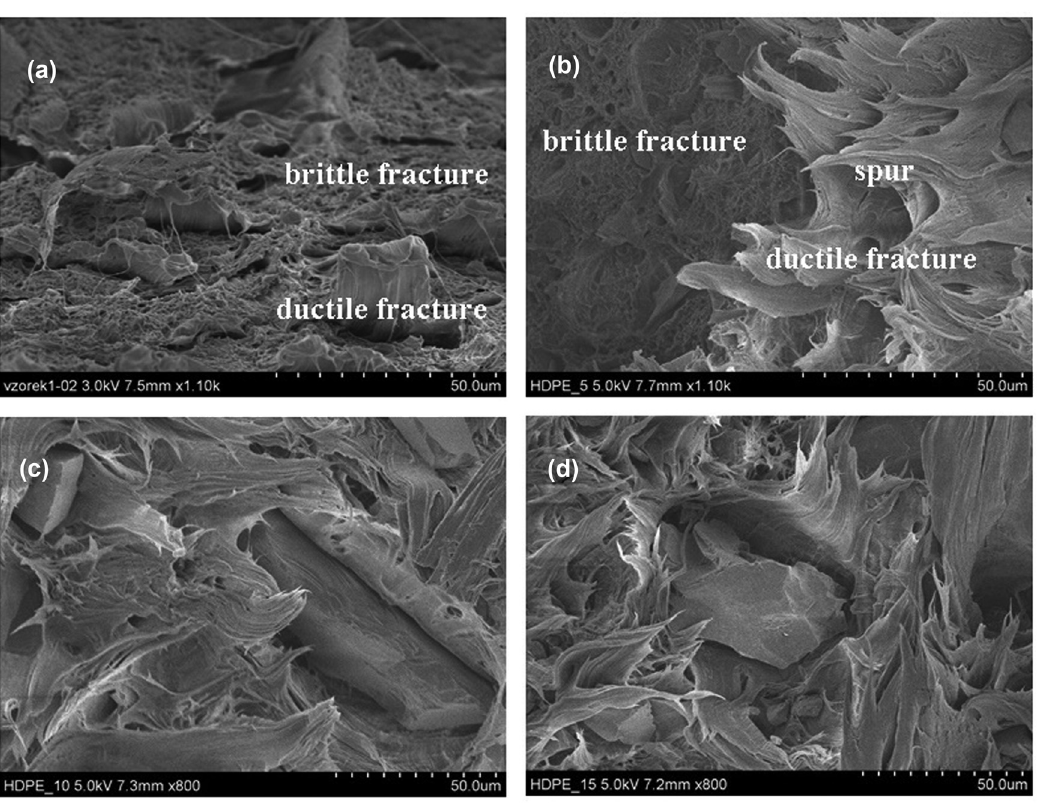
Figure 5: SEM images of the fracture surface after the tensile testing of the samples: ( a ) virgin HDPE, ( b ) 5 wt% perlite/HDPE composite, ( c ) 10 wt% perlite/HDPE composite, ( d ) 15 wt% perlite/HDPE composite. ( 50 mm/min applied deformation rate ) .